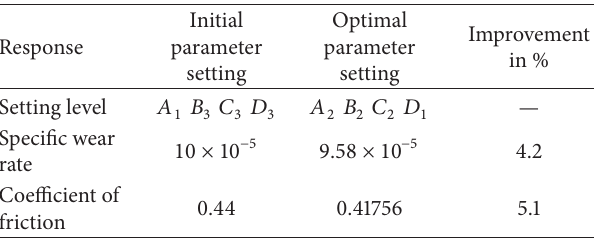
Table 11: Confirmation